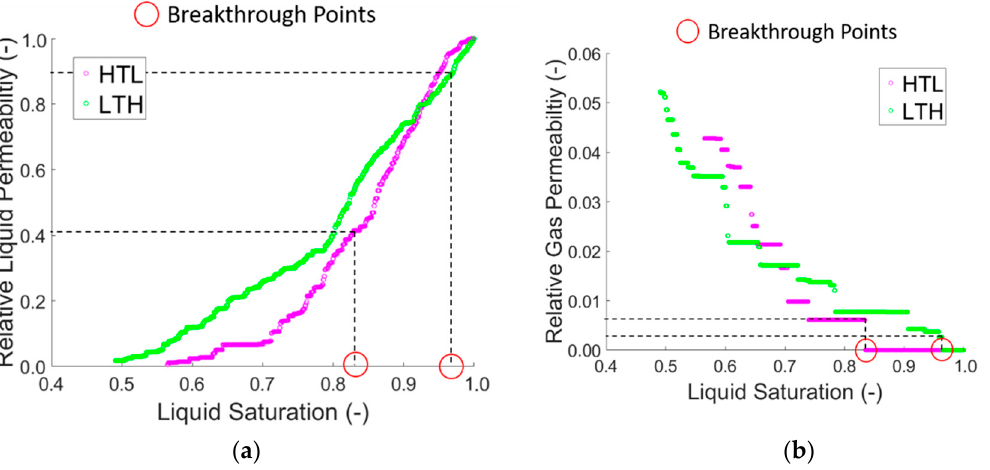
Figure 13. Comparison of ( a ) relative liquid and ( b ) gas permeabilities of LTH and HTL 3D pore networks corresponding to Figure 11. The breakthrough points denote the breakthrough of the gas phase to the second pore row of the pore networks. The absolute permeabilities computed for the empty networks are K = 1.24 × 10 − 12 m 2 (LTH) and K = 1.38 × 10 − 12 m 2 (HTL).